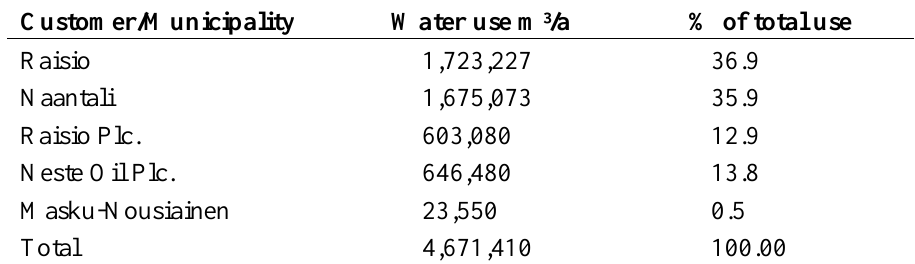
Table 1 . Raisio-Naantali Water Authority water use for